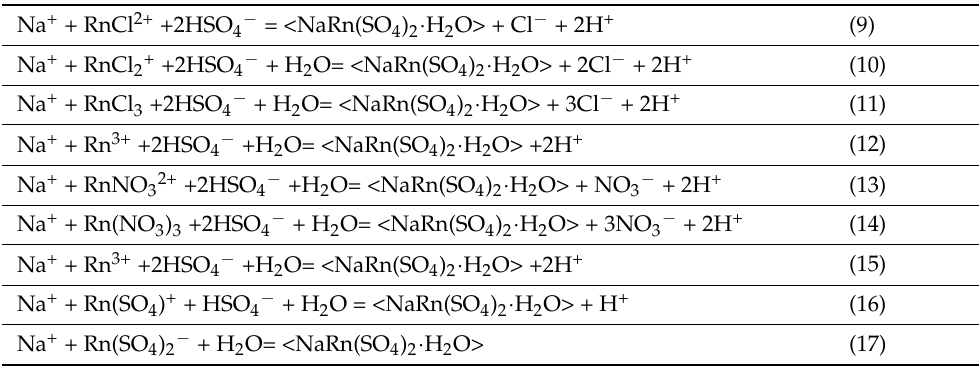
Table 6. Precipitation equations for various REE complexes into Na double salt as shown in Figure